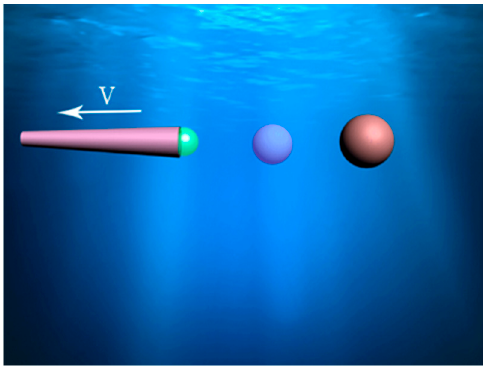
Figure 1. Schematic of the bubble formation and motion of the micromotor.